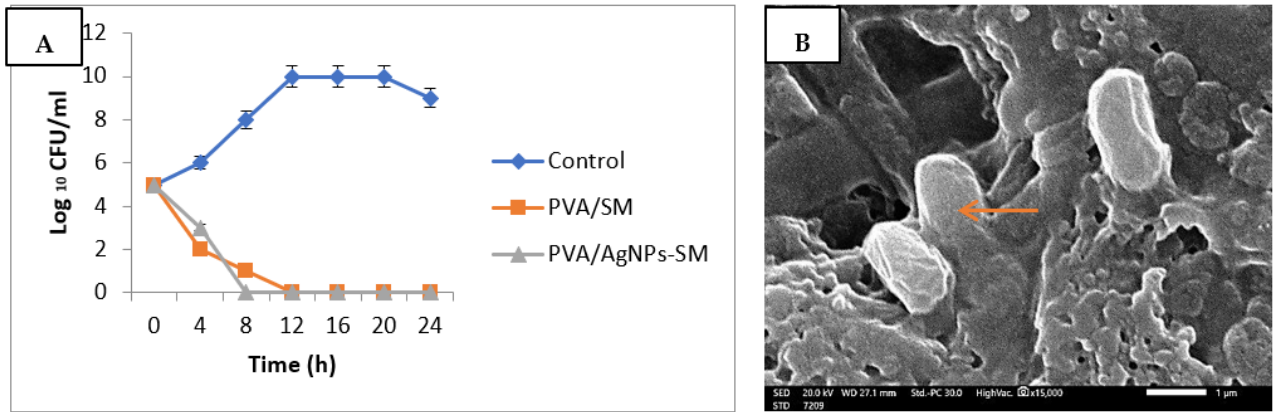
Figure 7. Antibacterial activity of PVA/AgNPs-SM nanofibers: Bacterial lethality curve ( A ), Scanning electron microscopic (SEM) image ( B ) (Arrow showing lysed bacterial cell).